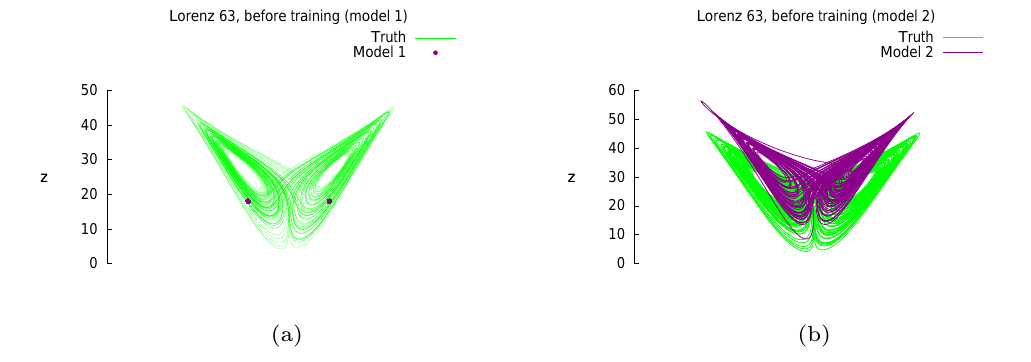
Figure 2. Trajectories of the imperfect models (purple), together with the true trajectory (green).